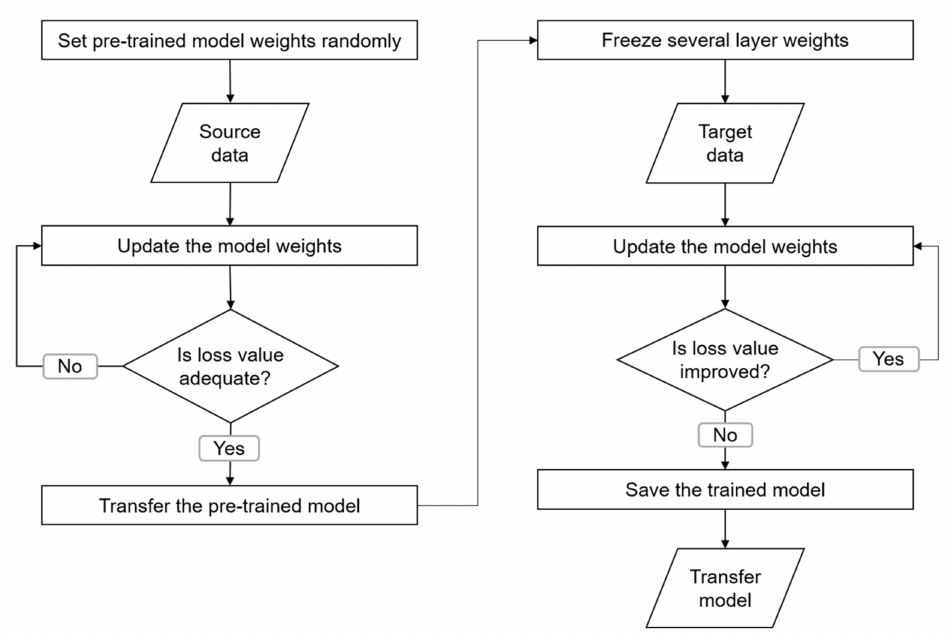
Figure 3. Flowchart of the model transfer and the fine-tuning